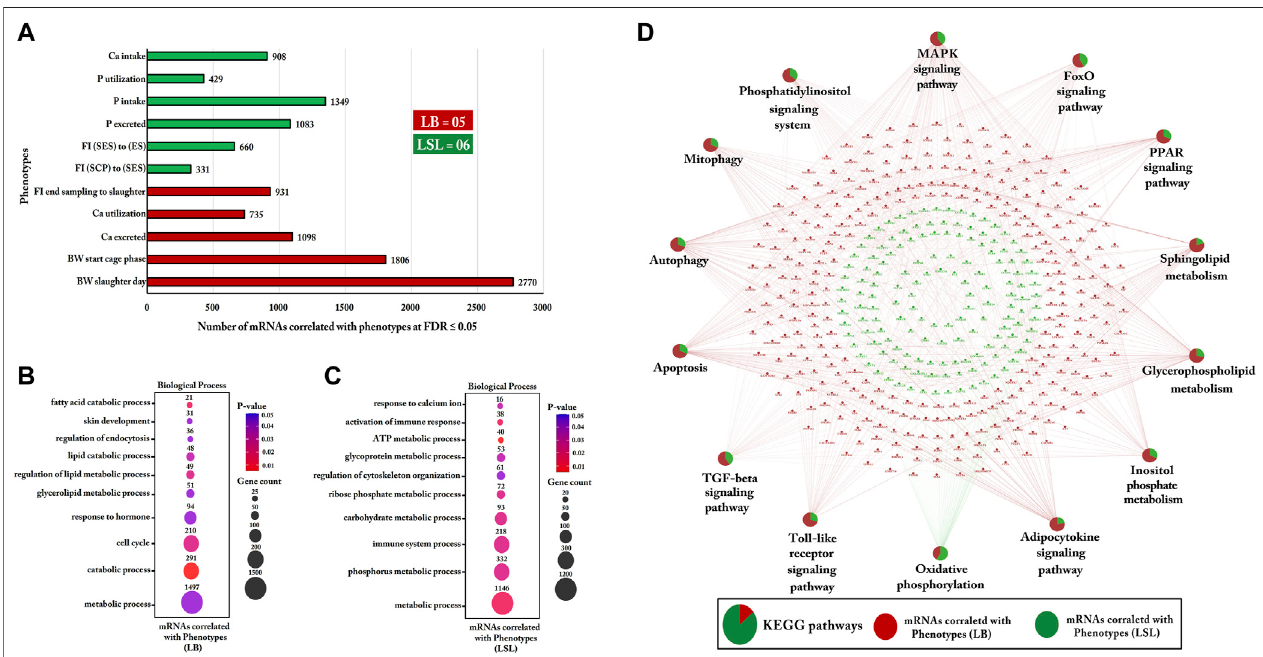
FIGURE 12 | Gene Ontology and KEGG pathways enrichment analysis of mRNAs correlated with phenotypic traits within LB and LSL. (A) The bar chart indicates the number ofmRNAscorrelated withphenotypictraitsat FDR ≤ 5%withinLB and LSL (r ≥ 0.5).Thegreen bar shows more abundant phenotypic traits inLSL, while the red bar depicts more abundant phenotypic traits in LB. (B) The transcripts correlated with phenotypic traits in LB were subjected to DAVID (version 6.8) for Gene Ontology (biological processes) enrichment analysis. (C) Gene Ontology (biological processes) enrichment analysis of transcripts correlated with phenotypic traits in LSL. The dot size represents the number of transcripts involved in each biological process, while the dot ’ s color indicates the p -value. (D) KEGG pathway enrichment analysisofmRNAscorrelatedwithphenotypictraitswithinLBandLSL.Thepiechartsindicatethestrain-speci fi cproportionsofmRNAscorrelatedwithphenotypictraits to the KEGG pathways. The red ellipse shows mRNAs correlated with phenotypic traits in LB, and the green ellipse depicts mRNAs correlated with phenotypic traits in LSL. KEGG pathways and biological processes with p ≤ 0.05 were considered signi fi